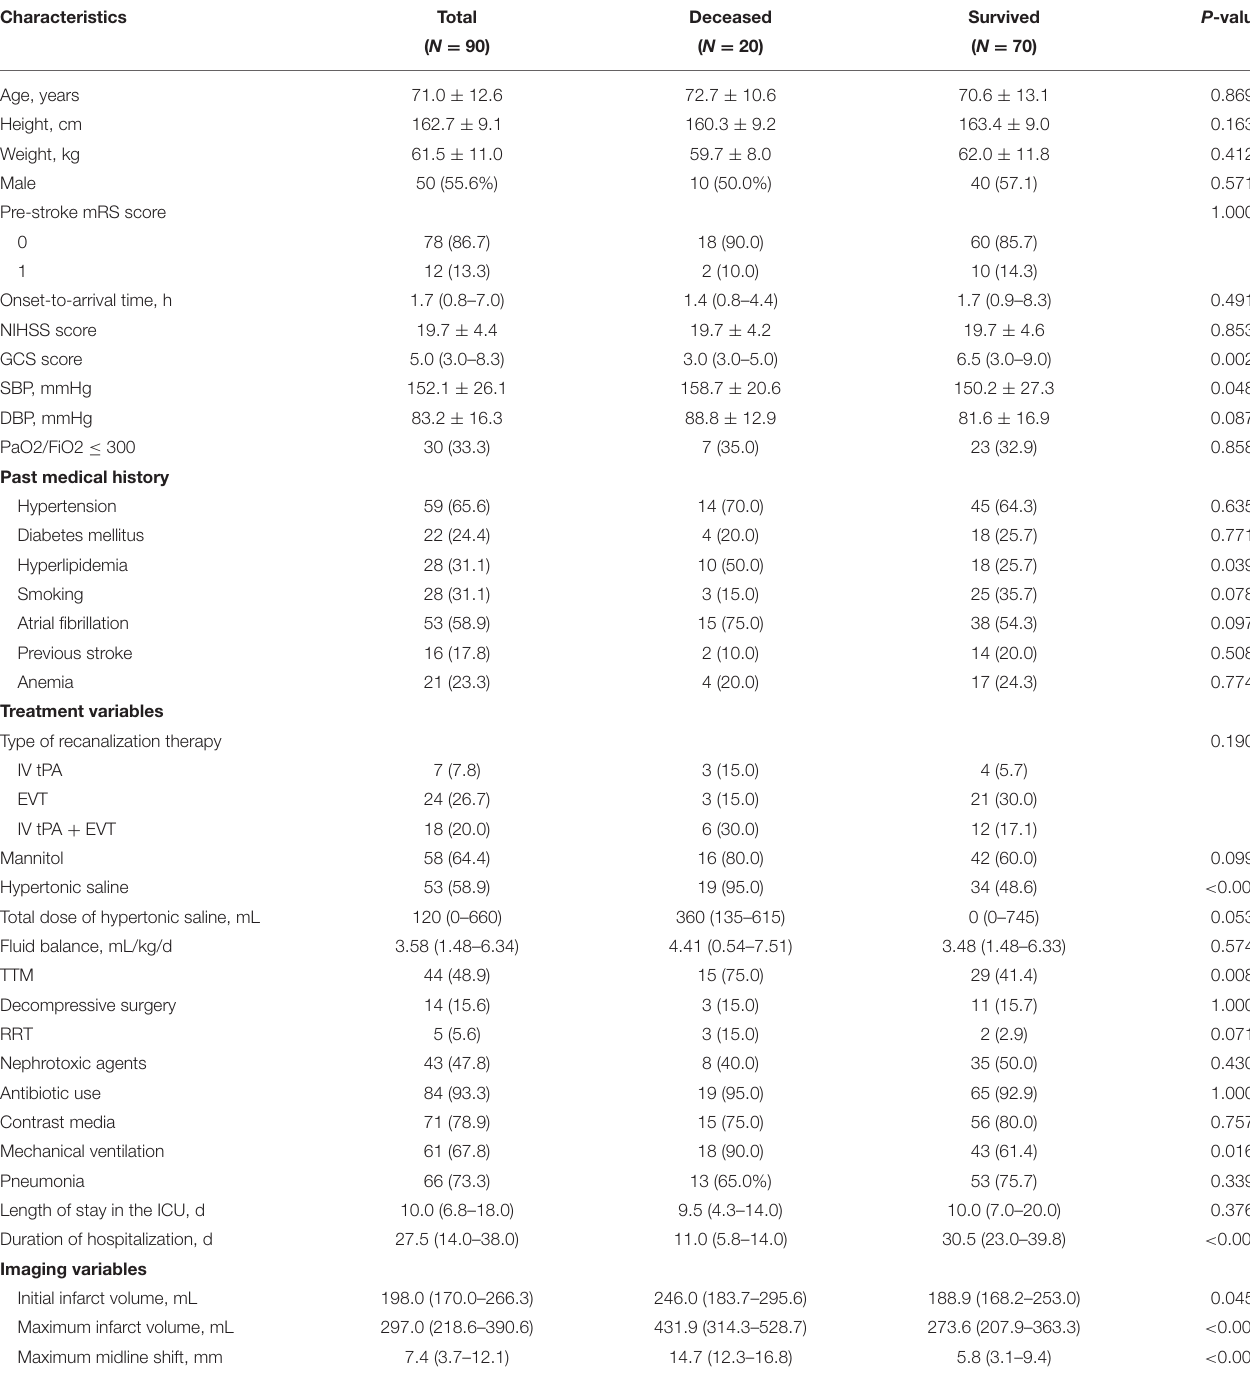
TABLE 1 | Patients’ baseline demographic and clinical characteristics.